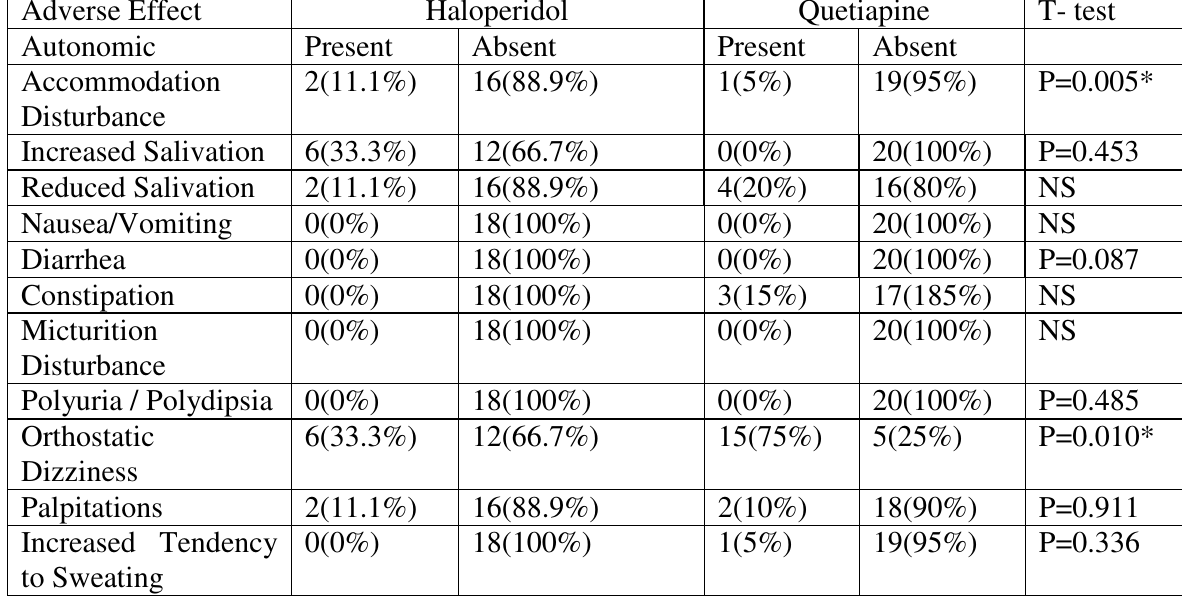
Table III: Autonomic side- effects observed in both the groups during the study Adverse